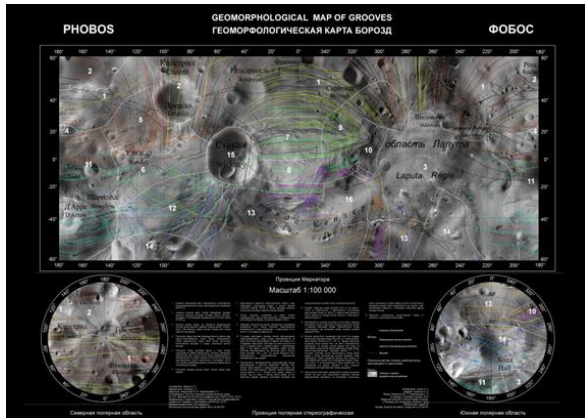
Figure 1. A layout of a new geomorphological wall map of Phobos (size A1) based on detailed study of grooves